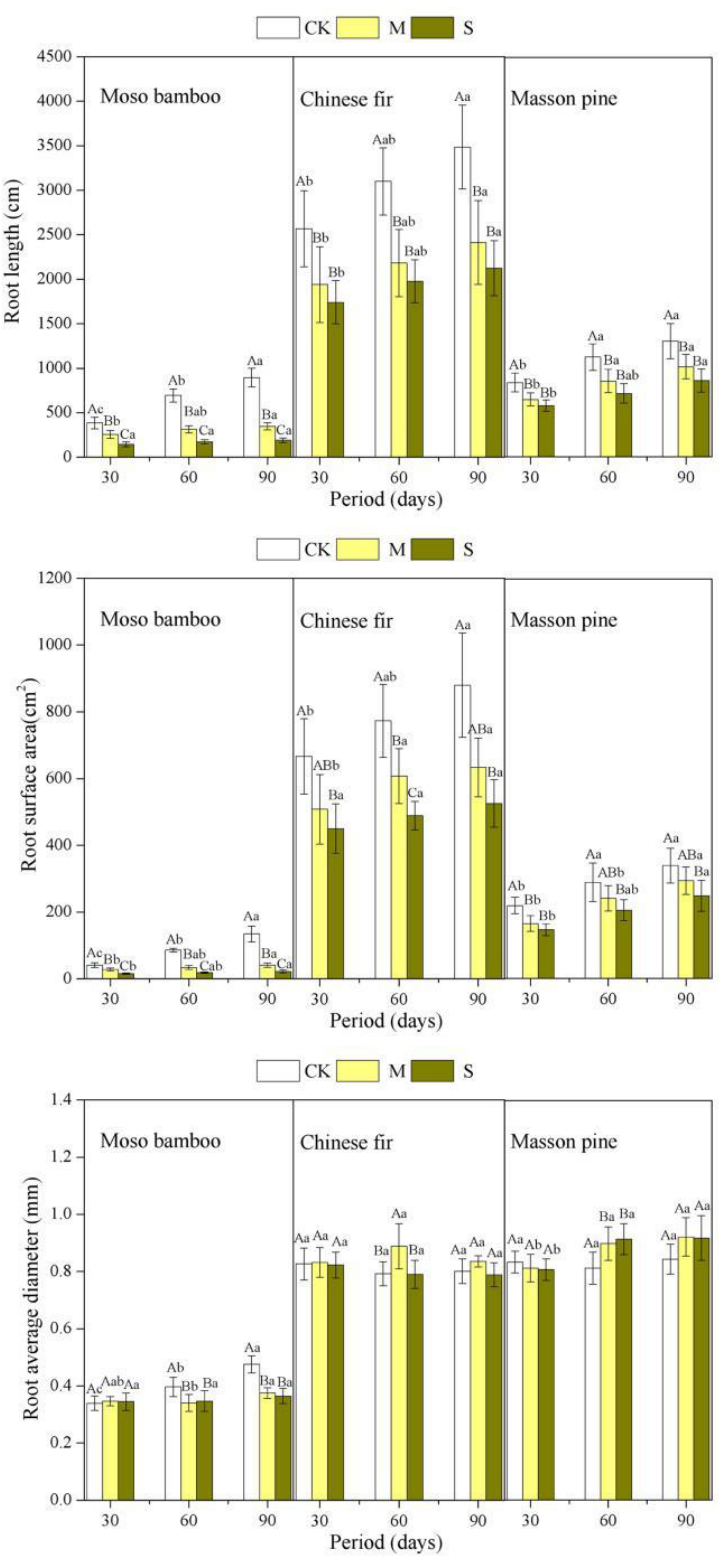
Figure 3. Effects of different drought treatments on root growth of the three species during three sampling periods. The capital letters denote significant differences among treatments ( p < 0.05), and the lowercase letters denote significant differences among periods ( p < 0.05). CK: the control, M: moderate drought, S: severe drought.